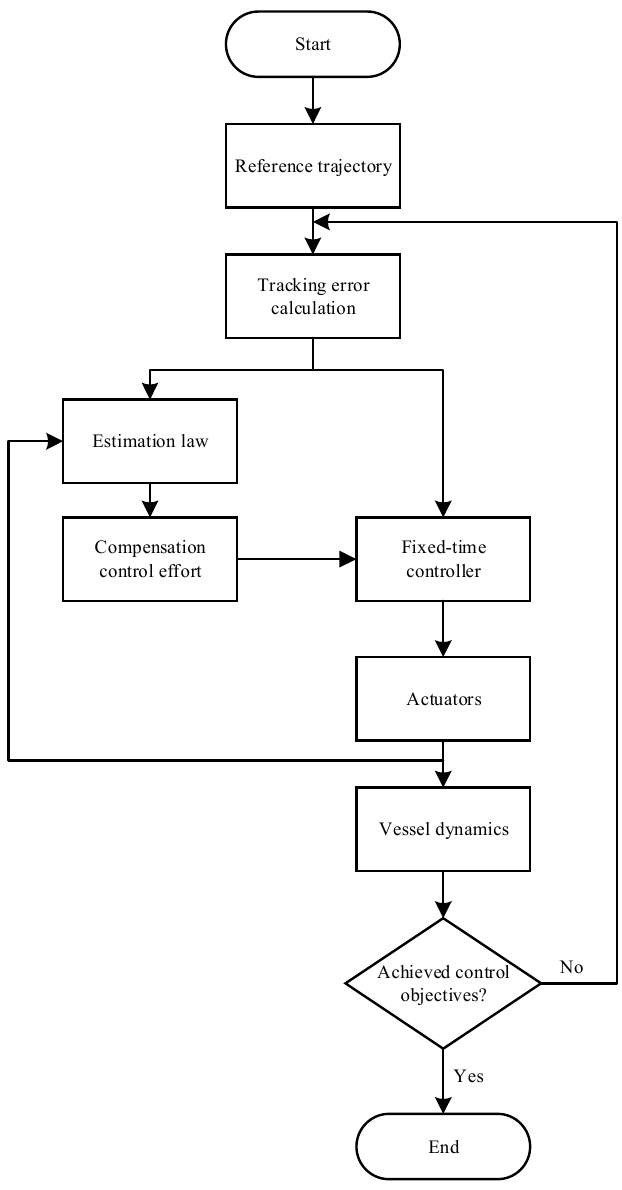
Figure 2. Flow chart of the Fixed ‐ DOTC for vessels.